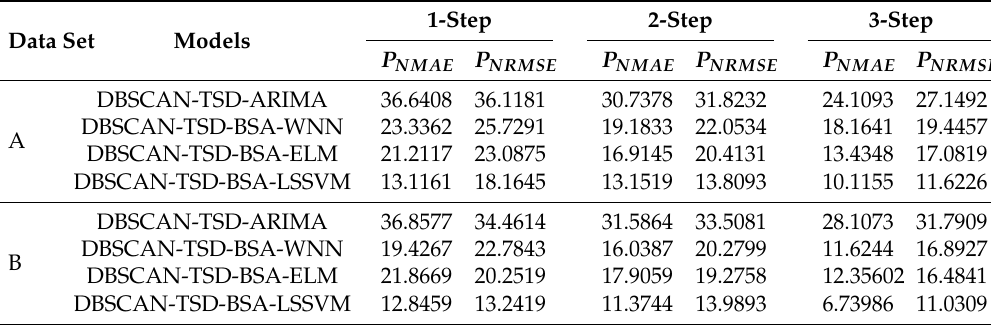
Table 6. Improved index P NMAE and P NRMSE of the four based forecasting models compared with the proposed model